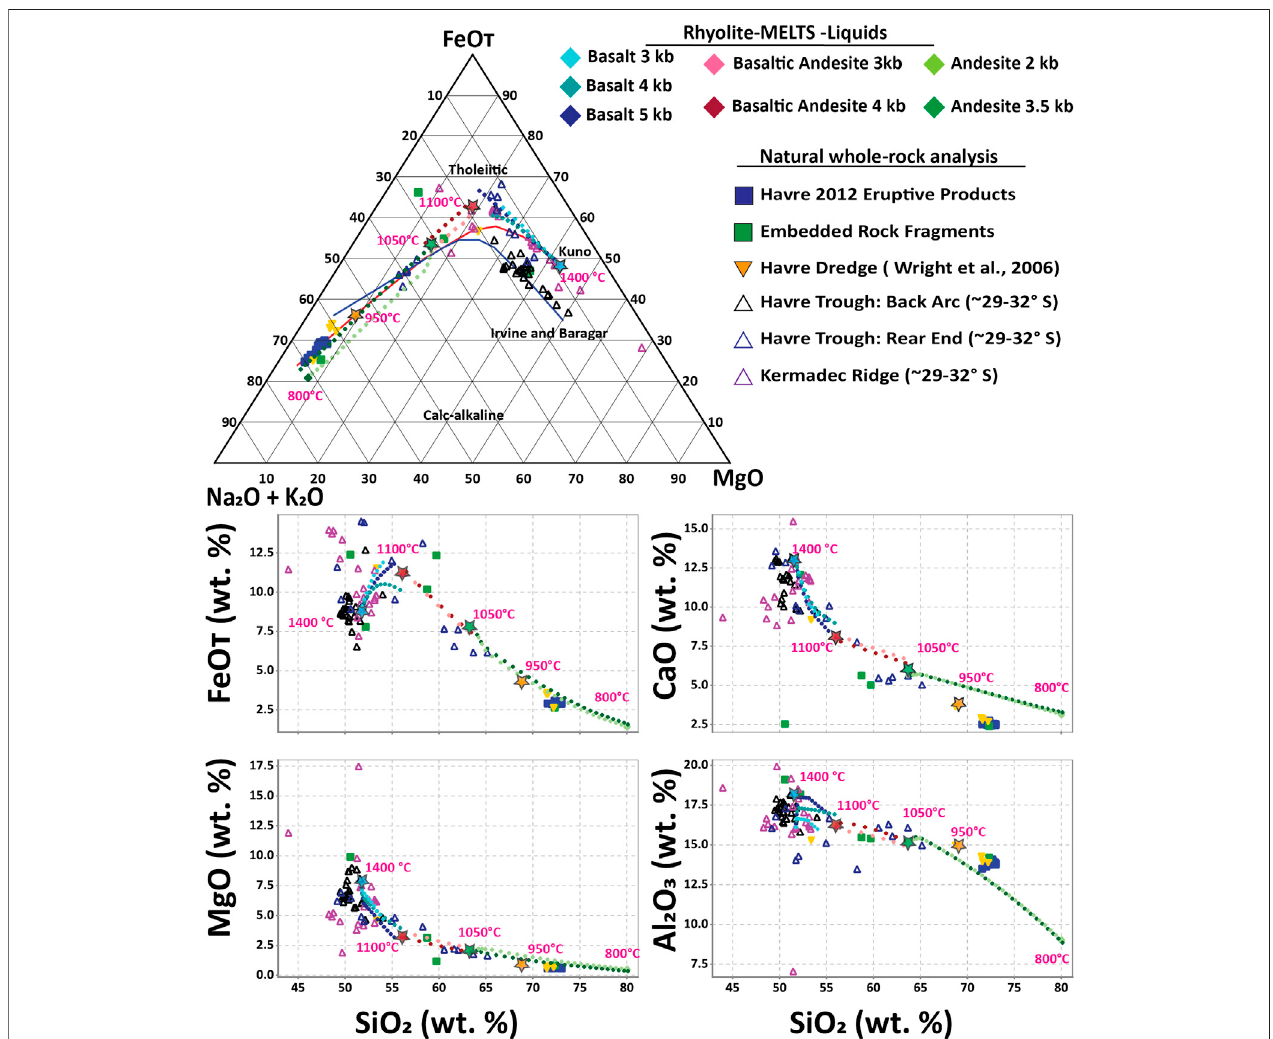
FIGURE 10 | Rhyolite-MELTS calculated liquids versus natural Kermadec arc compositions. Rhyolite-MELTS models calculated liquid lines of descent compared to measured whole-rock compositions of the Havre 2012 pumice and regional data sets. Rhyolite-MELTS models are presented as closed diamonds with the color denoting the variable pressures of runs conducted for each step in crystal fractionation, where other initial conditions are presented in Table 3 . Initial compositions of each step of crystallization are presented by stars (i.e., basalt = blue, basaltic andesite = red, andesite = green, and the resulting Havre Flank Dacite = yellow) with pink text denoting the initial temperature of each model. Additional dredge samples collected between ~29 and 32 ° S latitude from the Havre Trough back-arc and rear- end-arc and Kermadec Ridge Arc are presented here as open triangles derived from Hauff et al. (2021):https://doi.org/10.26022/IEDA/111723.